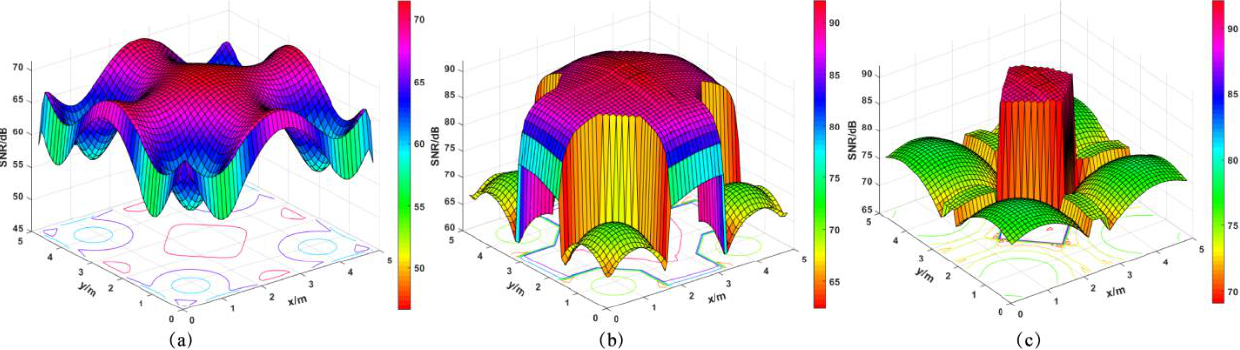
Figure 17. Diagram of the SNR distribution: no antenna ( a ), the initial structure ( b ), the optimally designed structure ( c ).